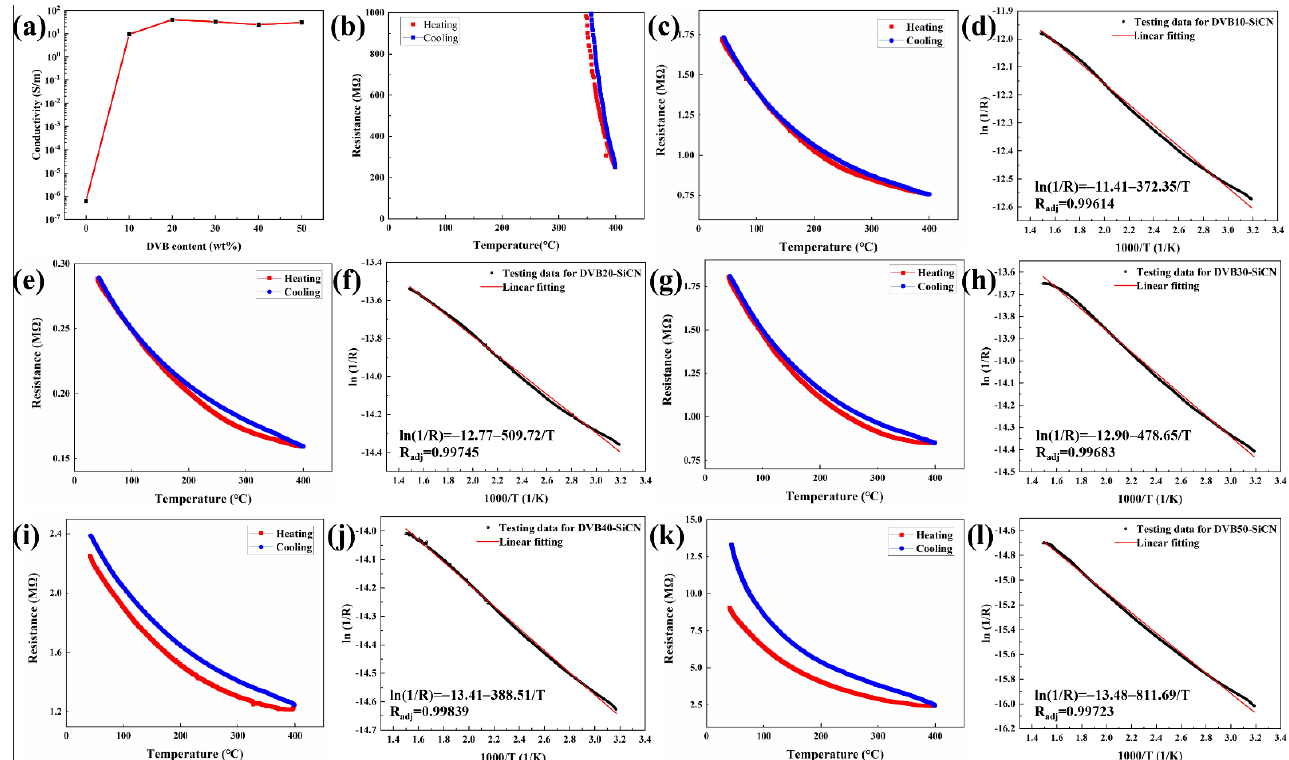
Figure 6. ( a ) Variation of SiCN conductivity at room temperature with DVB content. The resistance of film as a function of temperature: ( b ) SiCN film, ( c ) DVB10-SiCN film, ( e ) DVB20-SiCN film, ( g ) DVB30-SiCN film, ( i ) DVB40-SiCN film, ( k ) DVB50-SiCN film. A plot of resistance vs. temperature in the format ln(1/R) vs. 1000/T: ( d ) DVB10-SiCN film, ( f ) DVB20-SiCN film, ( h ) DVB30-SiCN film, ( j ) DVB40-SiCN film, ( l ) DVB50-SiCN film.